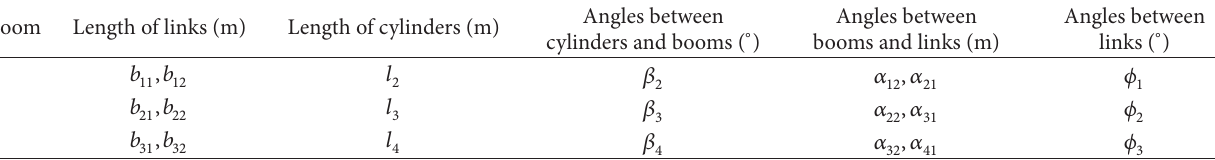
Table 2: Multibody manipulator luffing mechanism parameters.